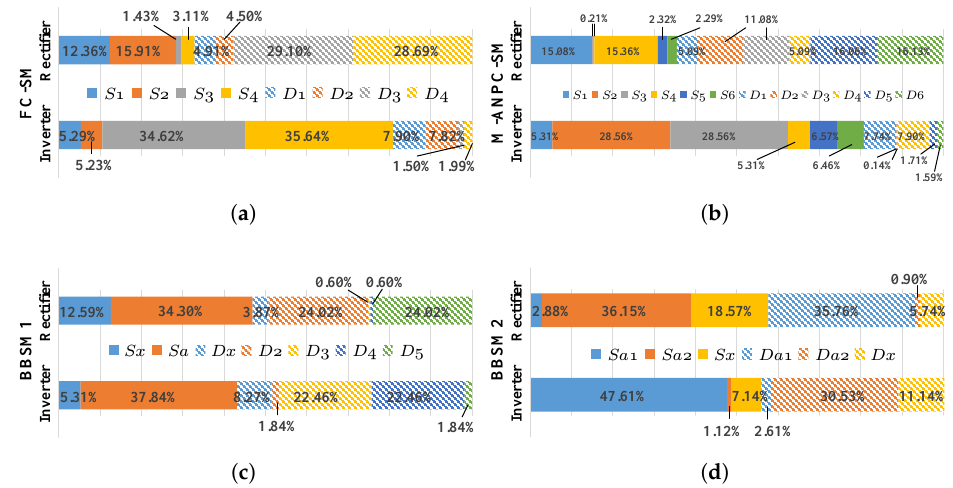
Figure 24. Loss distribution amongst SM devices: ( a ) FCSM, ( b ) M-ANPC-SM, ( c ) BBSM1, and ( d ) BBSM2.